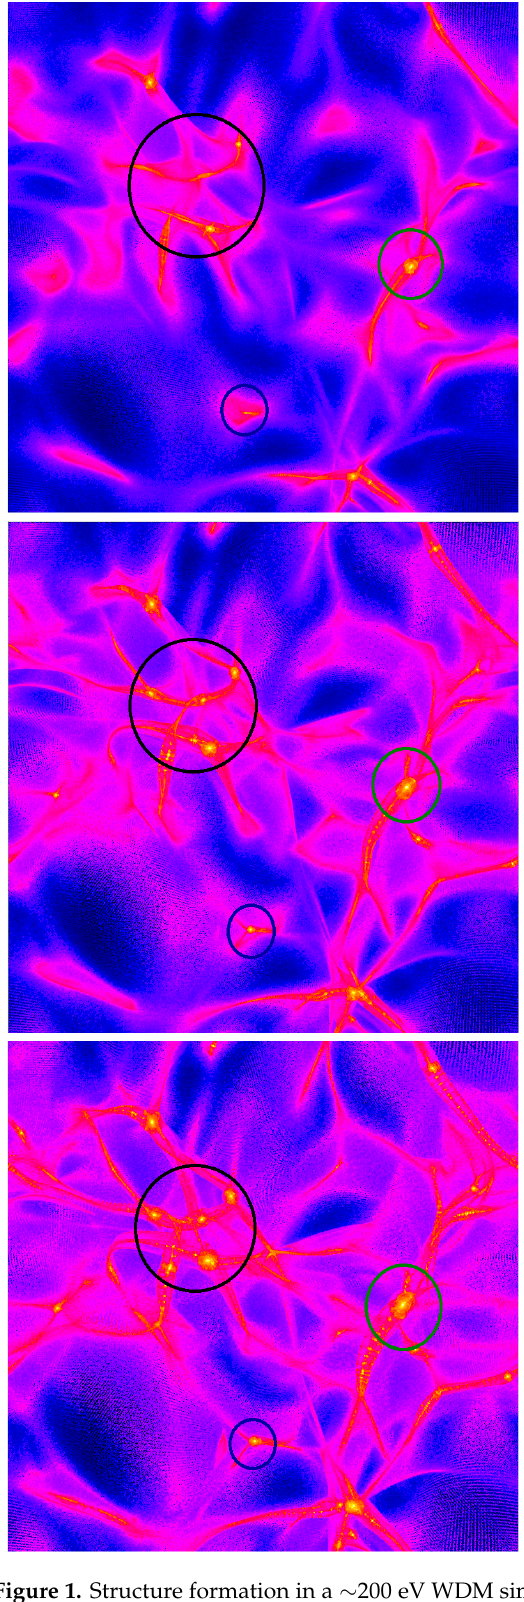
Figure 1. Structure formation in a ∼ 200 eV WDM simulation at redshift z = 2 ( upper panel ), z = 1 ( middle panel ) and z = 0 ( lower panel ) [17]. The different regions corresponding to different mecha- nisms are encircled: in green—a region where a large halo forms top-down, in black—a region where several halos are approaching merging, in blue—a halo forming late in an isolated